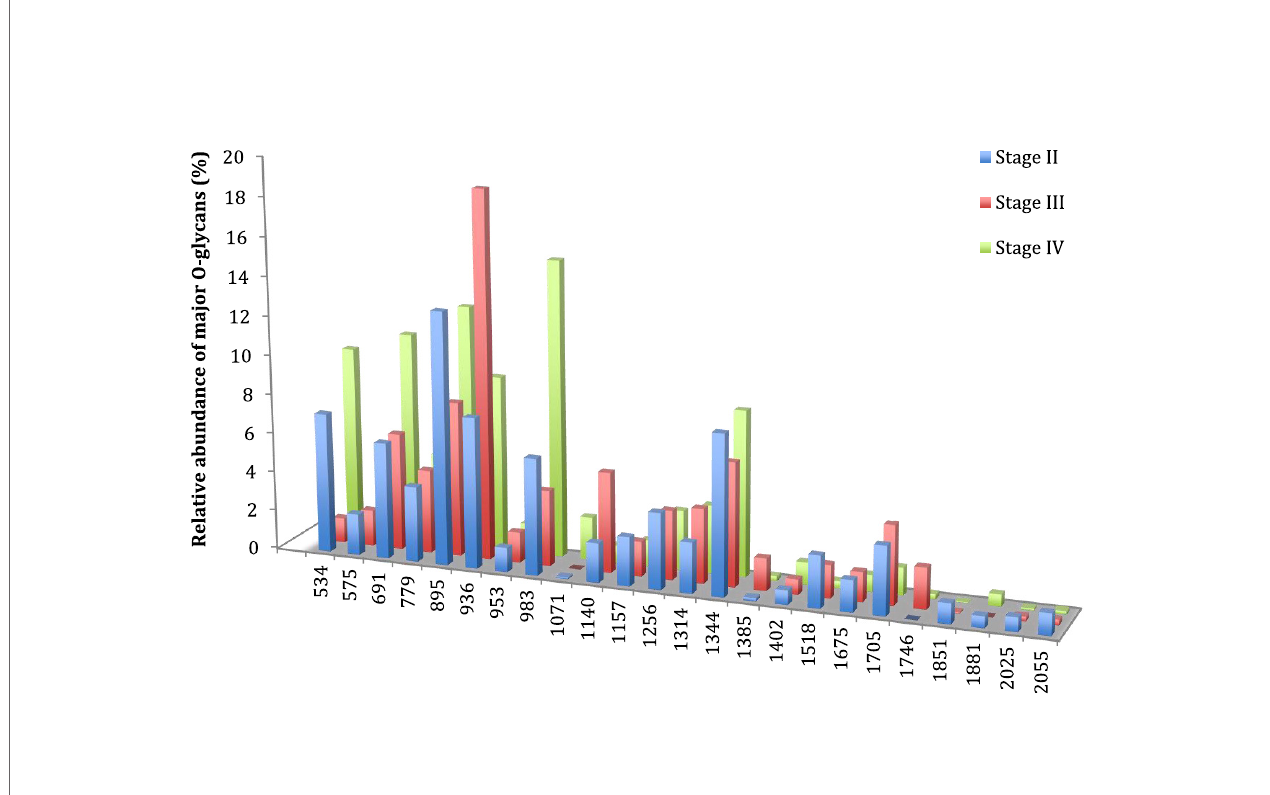
FigUre 3 | comparison of the relative abundance of major mucin O-glycans purified from tumors of stage ii ( n = 4), stage iii ( n = 3), or stage iV ( n = 3) . A low increase in the level of expression of ions at m/z 534, 691, and 983 was observed in stage IV colorectal tumors, compared to stages II and